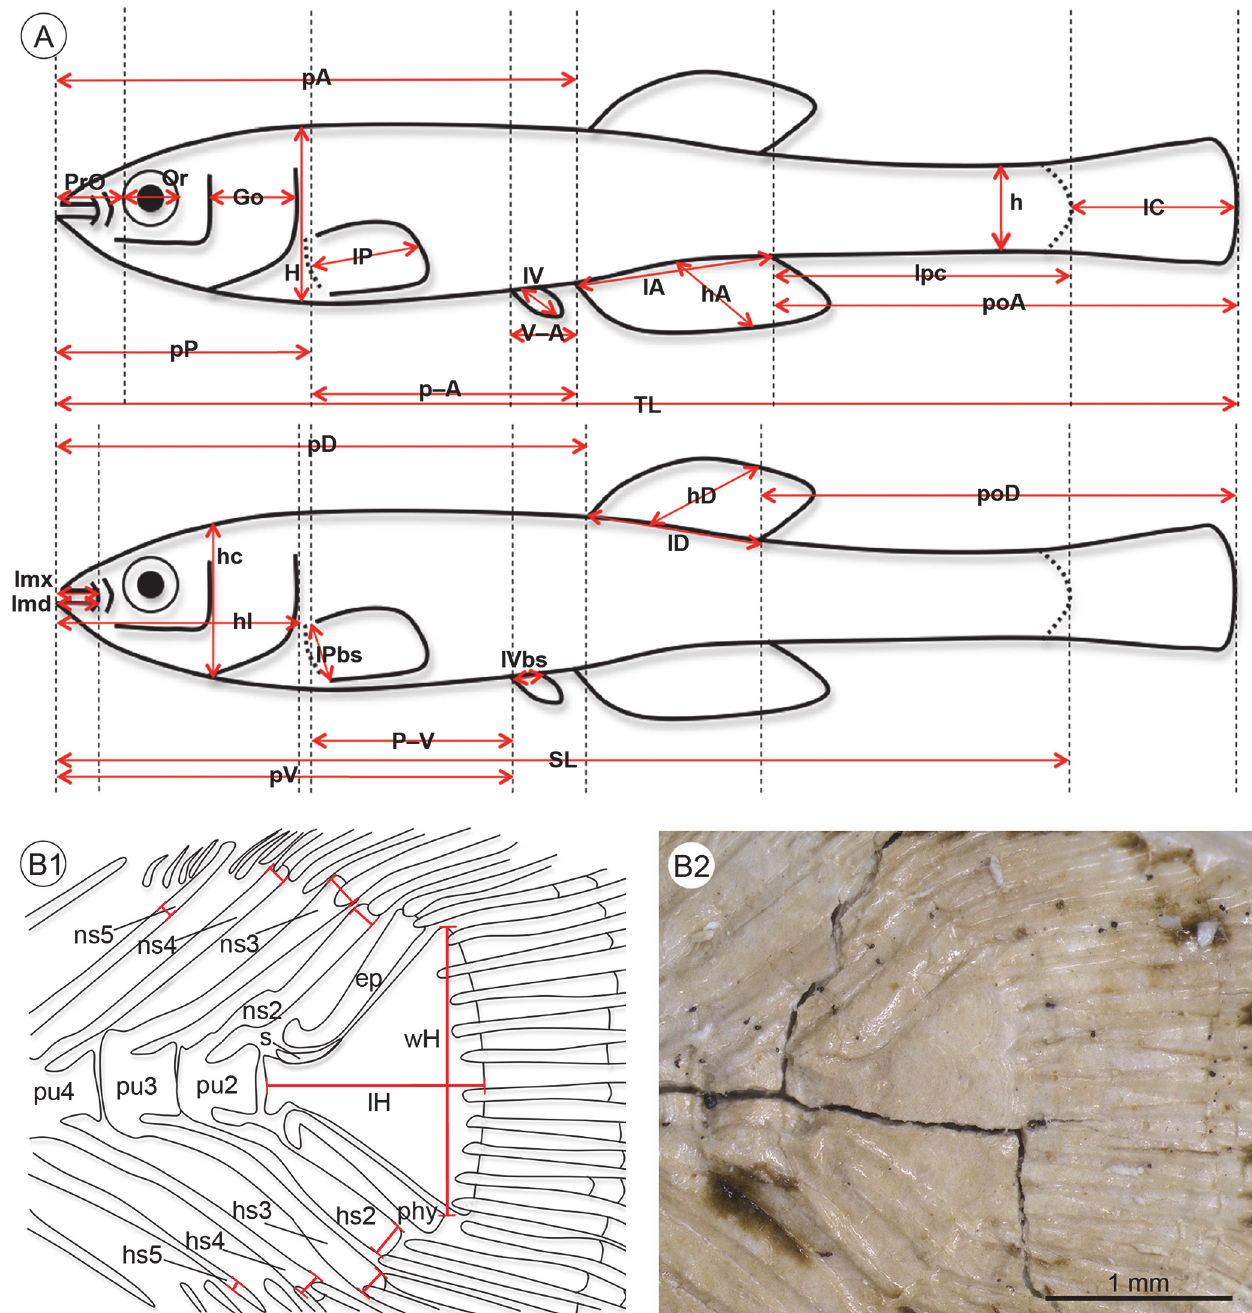
Fig 2. Schematic drawings indicating measurements used in this study. A , morphometric parameters; B1 – B2 measurements of hypural plate length and width and measurements of the spine widths on the caudal skeleton of † K . kipkechi sp. nov. (paratype 1200´04); note that the proximal part of the parhypural (with an anteroventral projection) does not overlap the terminal centrum, left lateral view. Abbreviations: ep, epural; Go, gill opening; H, maximum body depth; h, minimum body depth; hA, depth of anal fin; hc, head depth; hD, depth of dorsal fin; hs2 – 5, haemal spine of preural vertebrae 2 – 5; lA, length of anal fin base; lc, length of head; lC, length of caudal fin; lD, length of dorsal fin base; lmd, lower jaw length, i.e. distance from anteriormost point of lower jaw symphysis to posteriormost margin of mandibular joint; lH, length of hypural plate; lmx, upper jaw length, i.e. distance between anteriormost point of premaxillary and posteriormost point of maxillary; lP, length of pectoral fin; lPbs, length of pectoral fin base; lpc, length of caudal peduncle; lV, length of pelvic fin; lVbs, length of pelvic fin base; ns2 – 5, neural spine of preural vertebrae 2 – 5; Or, eye diameter; pA, preanal distance; P – A, distance between pectoral fin base and anal fin base; pD, predorsal distance; phy, parhypural; poA, postanal distance, i.e. from posterior end of anal fin to end of caudal fin rays; poD, postdorsal distance, i.e. from posterior end of dorsal fin to end of caudal fin rays; pP, prepectoral distance; prO, preorbital distance; pu2 – 4, preural vertebrae 2 – 4; pV, prepelvic distance; P – V, distance between pectoral fin base and pelvic fin base; s, stegural; SL, standard length; TL, total length; V – A, distance between pelvic fin base and anal fin base; wH, width of hypural plate. doi:10.1371/journal.pone.0123056.g002 PLOS ONE | DOI:10.1371/journal.pone.0123056 April 29,